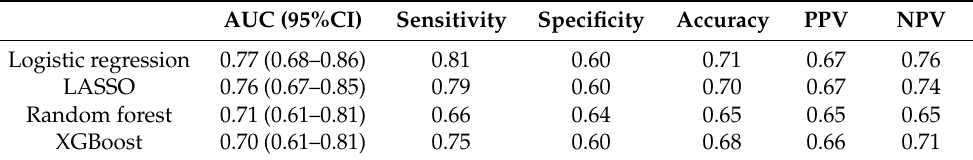
Table 3. Results of the model performances on test set ( N =